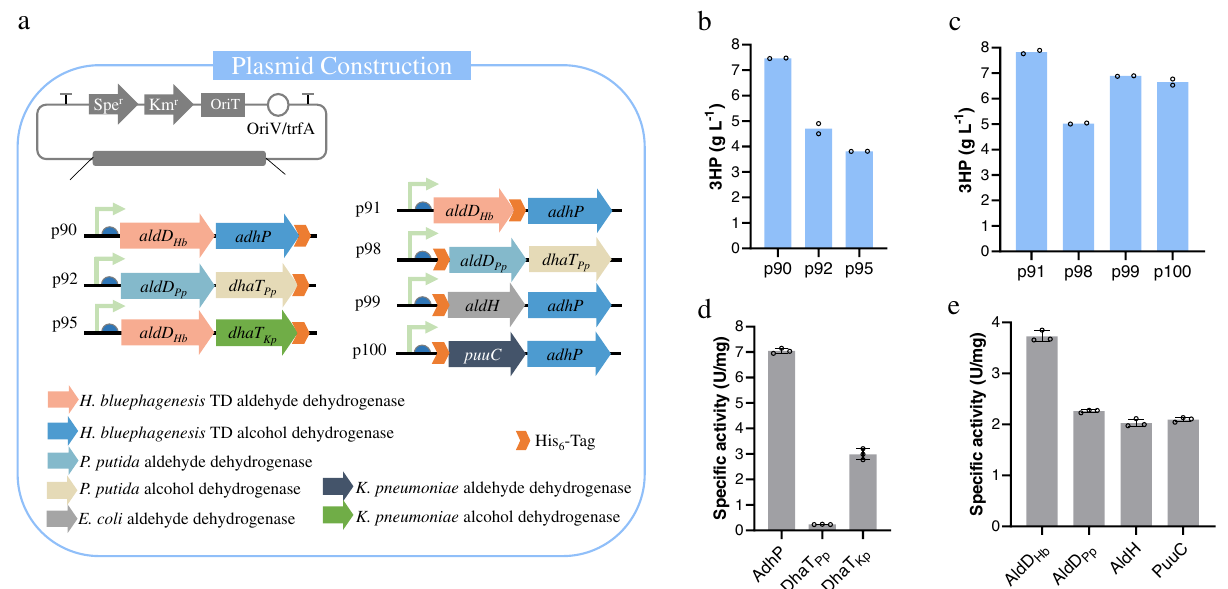
Fig. 3 Selection of ef fi cient enzymes for biosynthesis of 3HP in H. bluephagenesis . a Construction of the plasmids to express enzymes from different species. Following plasmids were constructed: plasmid p90 expressing adhP gene with a His-tag on C-terminal, p91 expressing aldD Hb gene with a His-tag on C-terminal, p92 expressing dhaT Pp gene with a His-tag on C-terminal and p98 expressing aldD Pp gene with a His-tag on N-terminal. The aldH gene, with a His-tag on N-terminal, was ampli fi ed via PCR using E. coli genomic DNA as a template and cloned into the p58 by replacing the aldD Hb gene. This plasmid is labeled as p99. The dhaT Kp or puuC gene, with a His-tag, was ampli fi ed via PCR using K. pneumoniae DSMZ 2026 genomic DNA as a template and cloned into the p58 by replacing the adhP or aldD Hb gene. These plasmids were labeled as p95 and p100. 3HP production of different alcohol dehydrogenases ( b ), and different aldehyde dehydrogenases ( c ). Cells were grown in the de fi ned minimal medium containing 20g L − 1 glucose, 20g L − 1 1,3-propanediol, and 3 g L − 1 acetic acid. All titers were obtained after 48h cultivation at 200 r.p.m. and 37°C. The initial pH of all shake- fl ask studies was 9. All data represent the mean of n = 2 biologically independent. The comparation of the various alcohol dehydrogenases oxidative activities ( d ), and various aldehyde dehydrogenases activities ( e ) in a puri fi ed enzyme. All data represent the mean of n = 3 biologically independent samples and error bars show s.d.